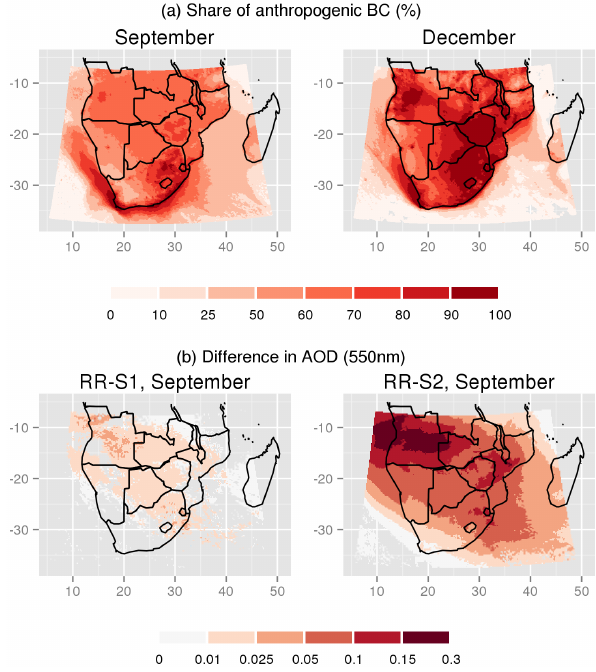
Figure 10. (a) Contribution of anthropogenic BC sources to BC concentrations, (b) contribution of anthropogenic BC sources to AOD (left: contribution of anthropogenic BC only, right: contri- bution of anthropogenic BC and co-emitted aerosols). For (b) , the model results have been interpolated to a lon-lat-grid of 0 . 2 ◦ × 0 . 2 ◦ , and only grid cells statistically significant at a confidence level of 95% are